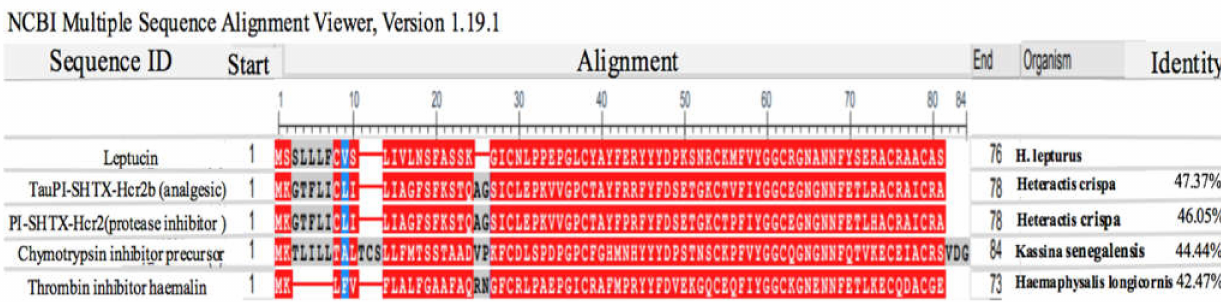
Figure 1. The amino acid and ORF sequence of leptucin; the H. lepturus analgesic peptide. The area of the signal peptide and mature chain are colored gray and black respectively.